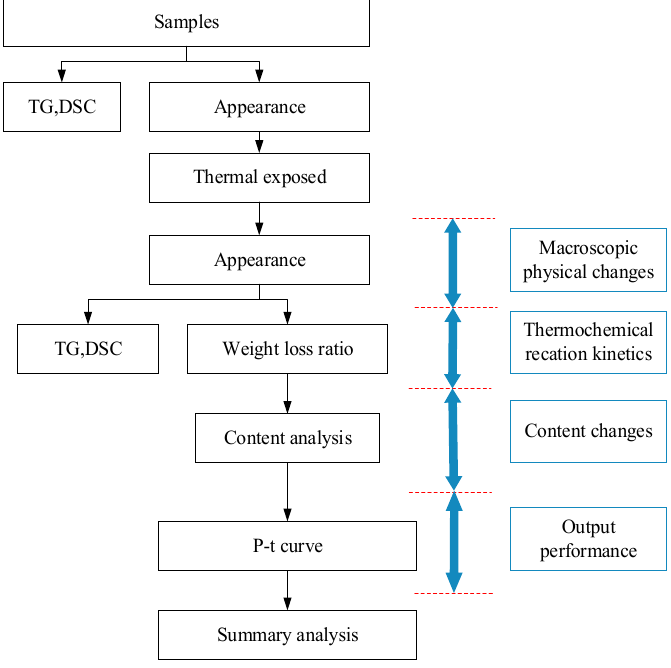
Figure 1. Experimental process scheme.